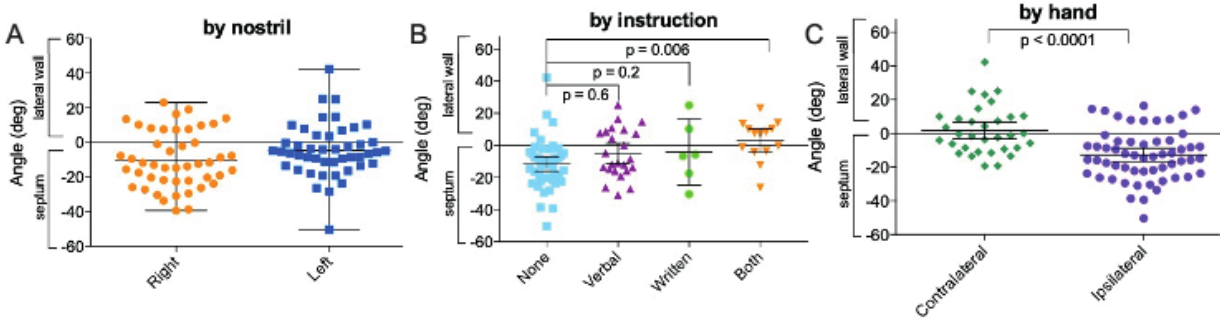
Figure 5. Intranasal corticosteroid septal angle by nostril, instruction level and by hand of application. (A) The mean INCS-Septal angle for the right naris (orange circles) was -10.50 (toward the septum) and the mean angle for the left was -4.50 (toward the septum). (B) Without instruction the mean INCS-Septal angle was -11.70 (toward the septum; blue squares). The mean angle with verbal instruction was -5.00 (toward the septum; up purple triangle) and was -4.20 written instruction (green circles). Patients who reported both written and verbal instruction had a mean INCS-Septal angle of 3.25 (away from the septum; down orange triangle; p = 0.006) (C) The average angle using the contralateral had was 1.80 (away from the septum; green triangles) compared to -12.70 using the ipsilateral hand (toward the septum; purple circles;